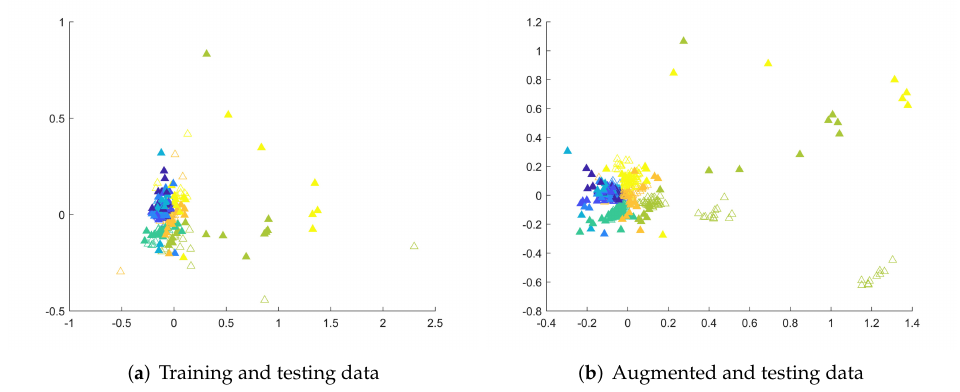
Figure 6. The 2D MDS embeddings of DTW dissimilarities between testing and training or testing and augmented sequences from the MSRA I dataset. Colors differentiate the classes, the filled triangles denote testing